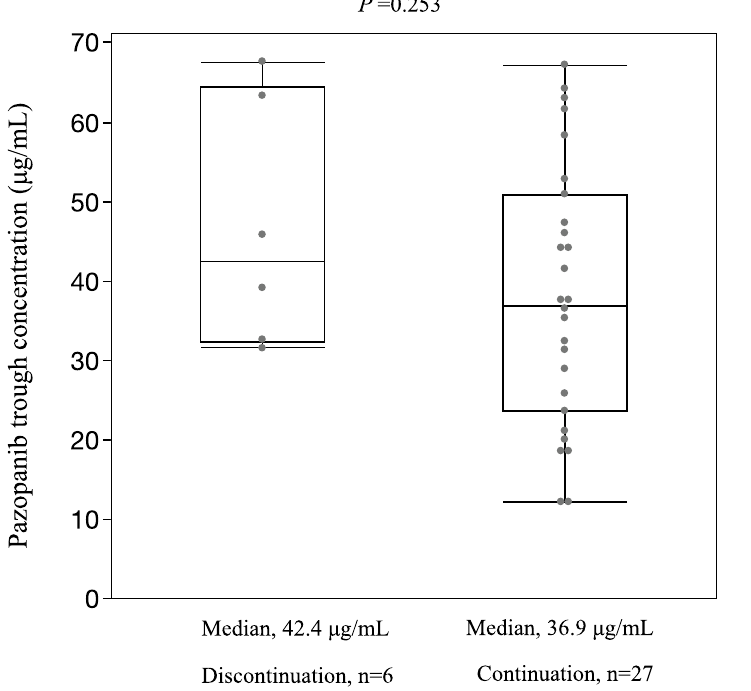
Figure 4. Plasma pazopanib trough levels in patients with discontinued or continued treatment. Statistical tests were compared using a Mann–Whitney U test